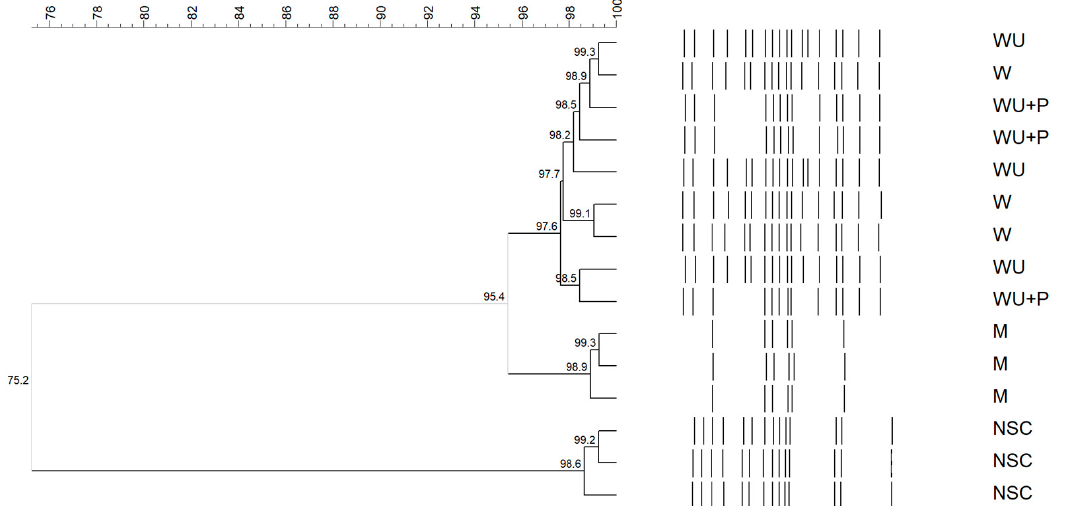
Figure 3. UPGMA cluster analysis, using Pearson correlation, of (GTG)5 rep-PCR fingerprints of total-community DNA extracted from the natural starter culture (NSC), NSC grown in ewe’s milk (M), in whey (W), in whey ultra fi ltered (WU), and in whey ultra fi ltered and supplemented with bacteriological peptone (WU + P). Three replicates for each sample were performed.